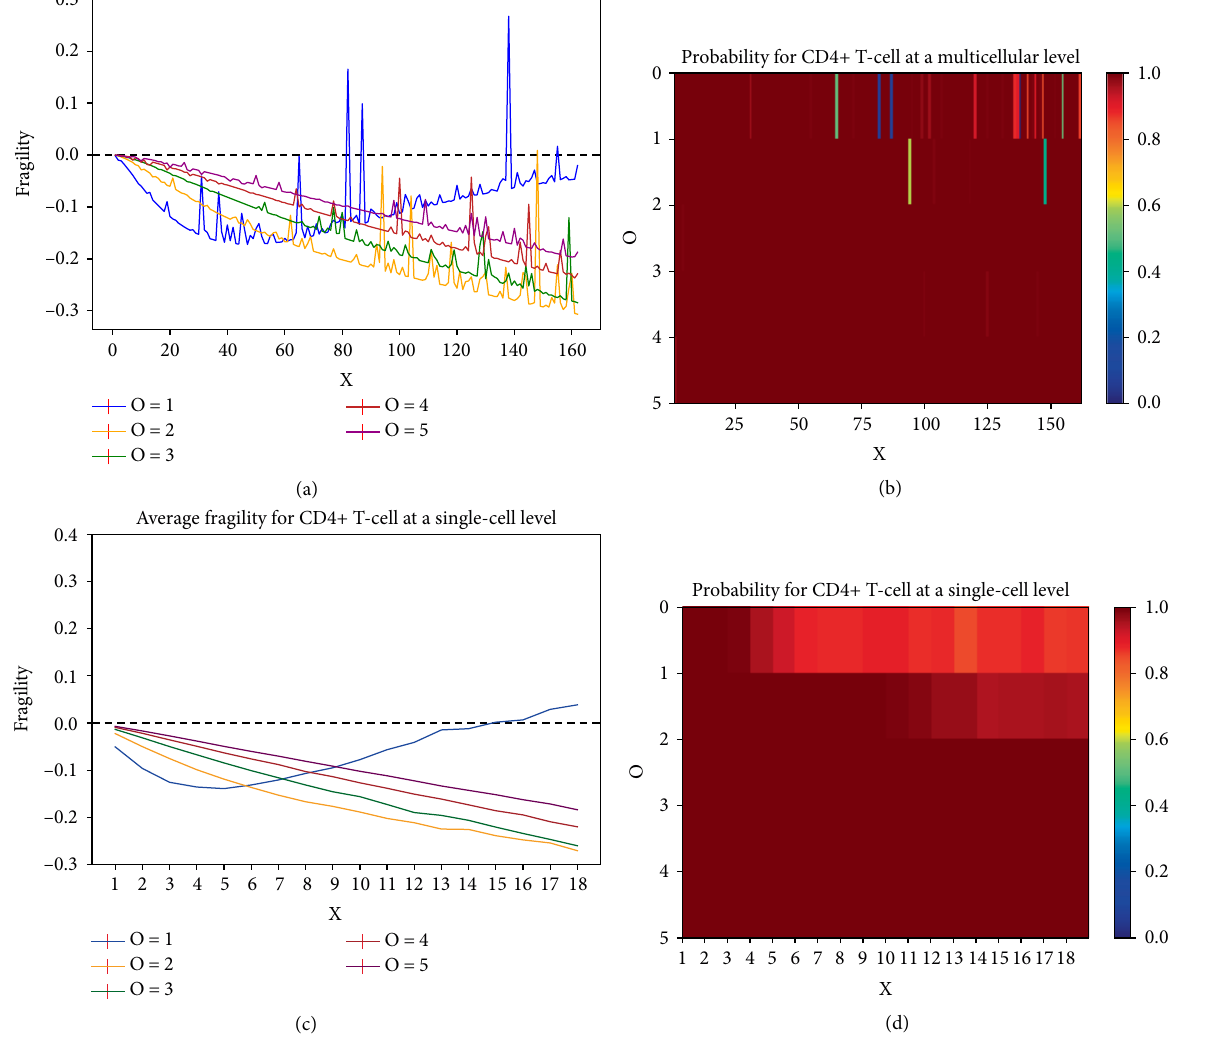
Figure 8: Average fragility and the probability of generating antifragile networks in multilayer and single‐layer CD4+ T‐cell networks. (a) Fragility for CD4+ T‐cell at a multicellular level. (b) Probability for CD4+ T‐cell at a multicellular level. (c) Fragility for CD4+ T‐cell at a single‐cell level. (d) Probability for CD4+ T‐cell at a single‐cell